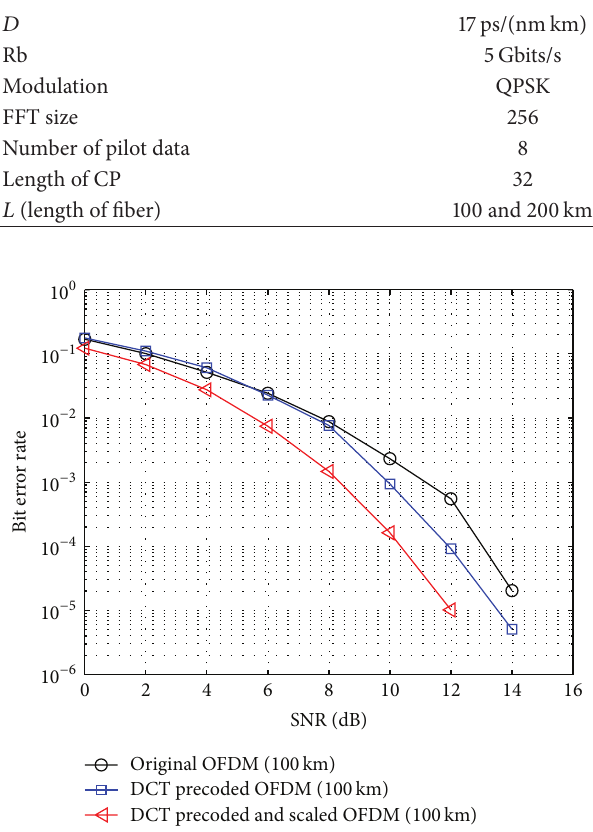
Figure 3: BER performance comparison over 100 km fiber channel.